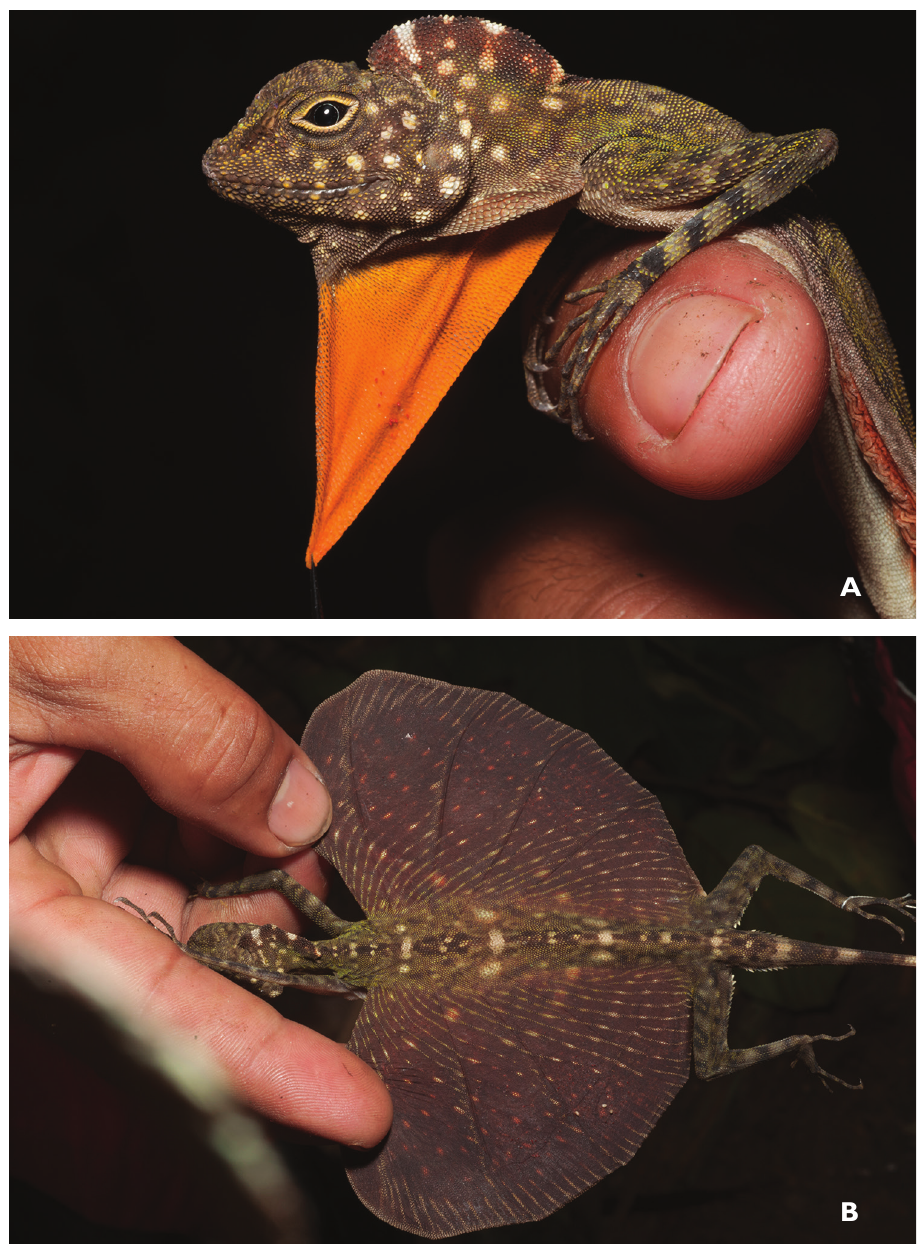
Figure 41. Draco mindanensis , a seldom-recorded forest species from Agusan del Norte and Agusan del Sur Provinces . A Close-up of head, male specimen B Male patagial coloration. Photos: RMB (from the Municipality of Balangiga, Samar Island; specimen deposited at